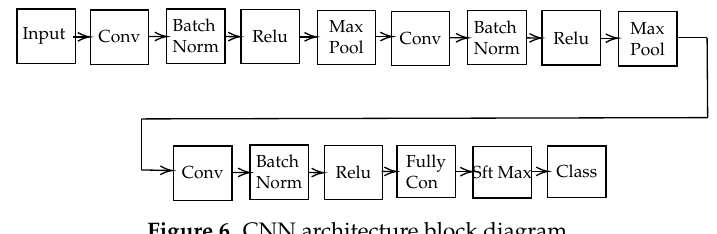
Figure 6. CNN architecture block